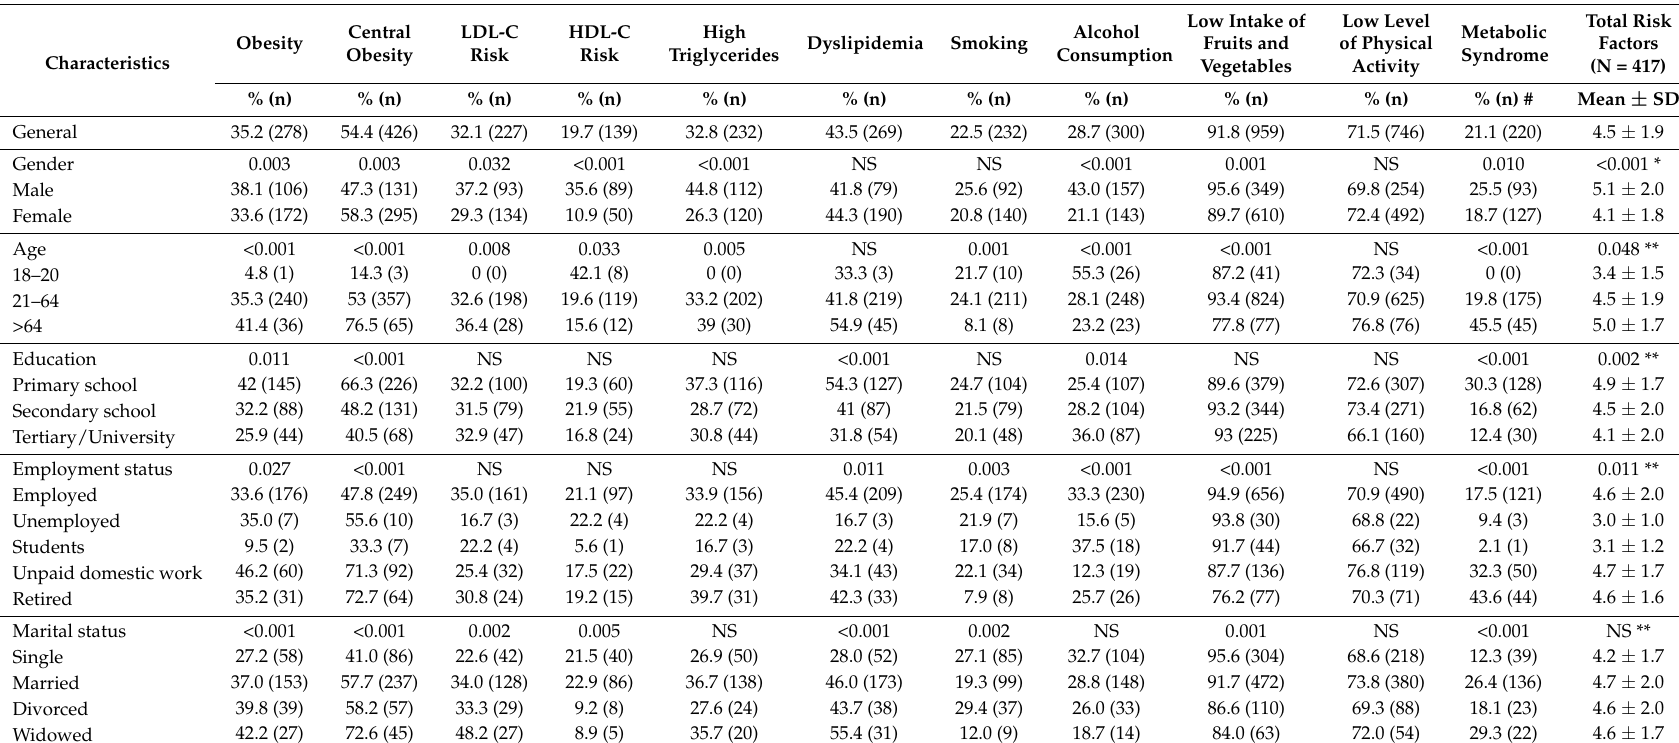
Table 3. Risk factors for chronic diseases associated with the anthropometry, lifestyle and blood biochemical analysis of